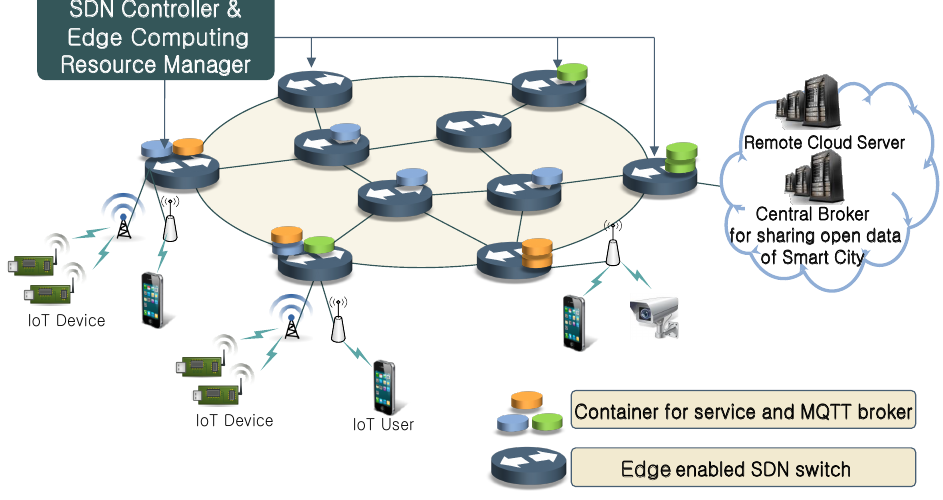
Figure 2. Edge computing